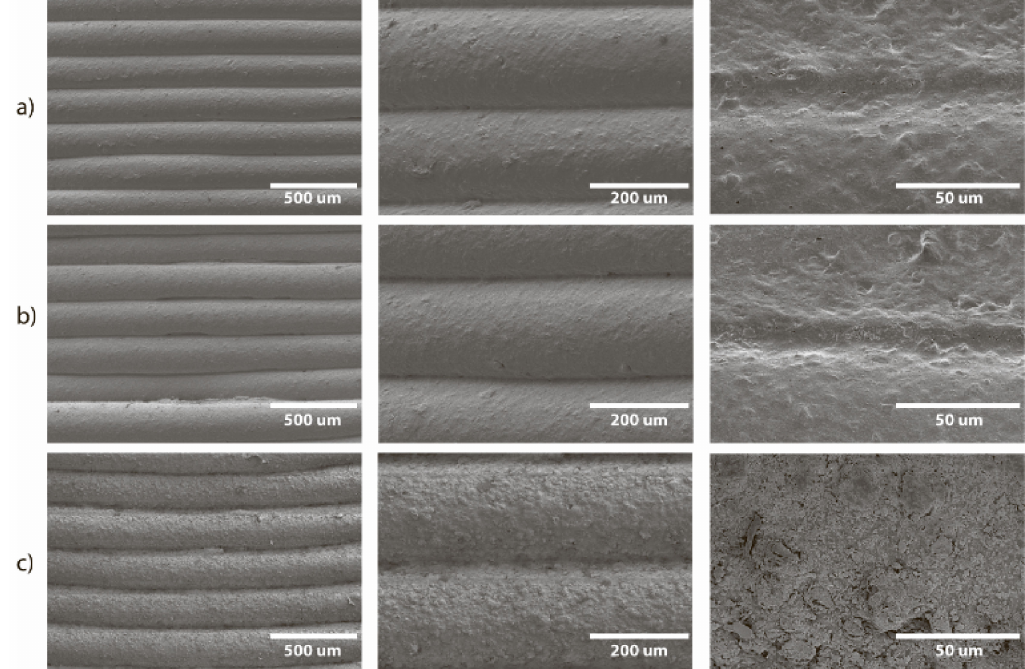
Figure 11. SEM images of the 3D printed reactor surface with PP at different magnifications: ( a ) before the reaction, ( b ) after one cycle of reaction of 1,4-bis(phenylthio)buta-1,3-diene synthesis (total reaction time 1 h at 60 ◦ C), and ( c ) after five cycles of vinyl derivative synthesis (total reaction time is 5 h at 130 ◦